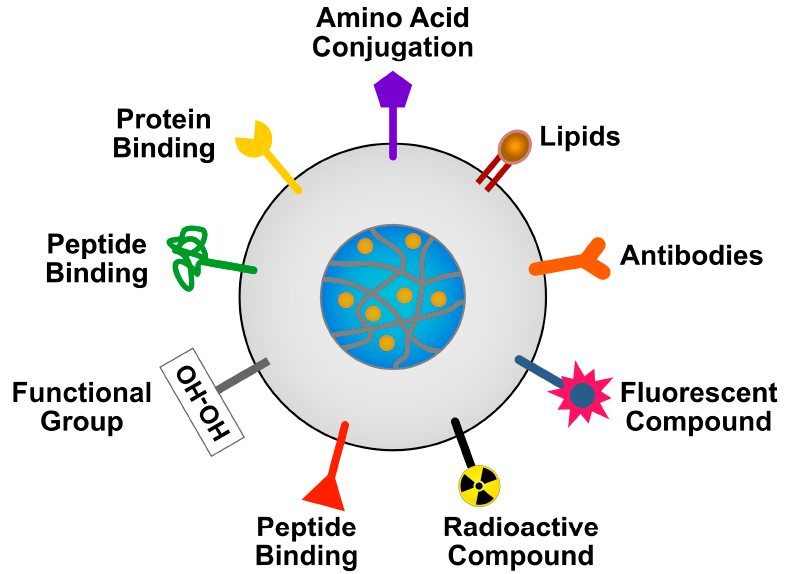
Figure 7. Different approaches to modify surfaces of nanoparticles (NPs) to target cancer cells.